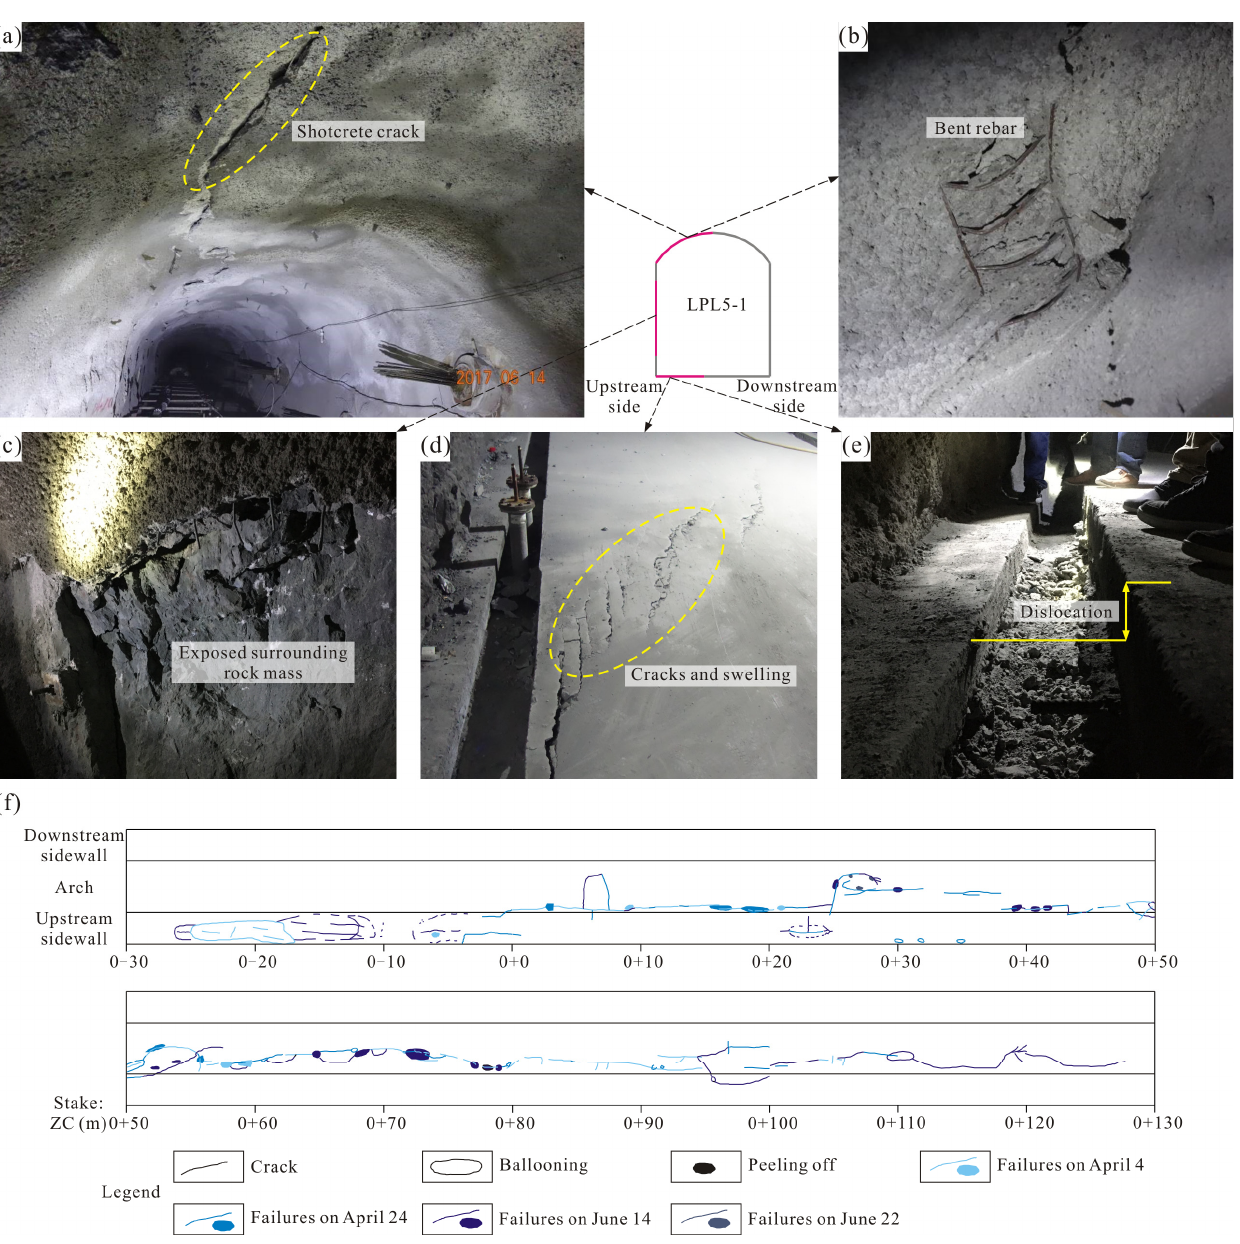
Figure 5. Failures in the drainage gallery LPL5-1: ( a ) a shotcrete crack and ( b ) exposed bent rebar at the upstream arch, ( c ) peeling of shotcrete on the upstream sidewall, ( d ) cracks and swelling of floor concrete, ( e ) dislocation on the floor and ( f ) failure distribution at stake from ZC0–030 m to ZC0+130 m in 2017.